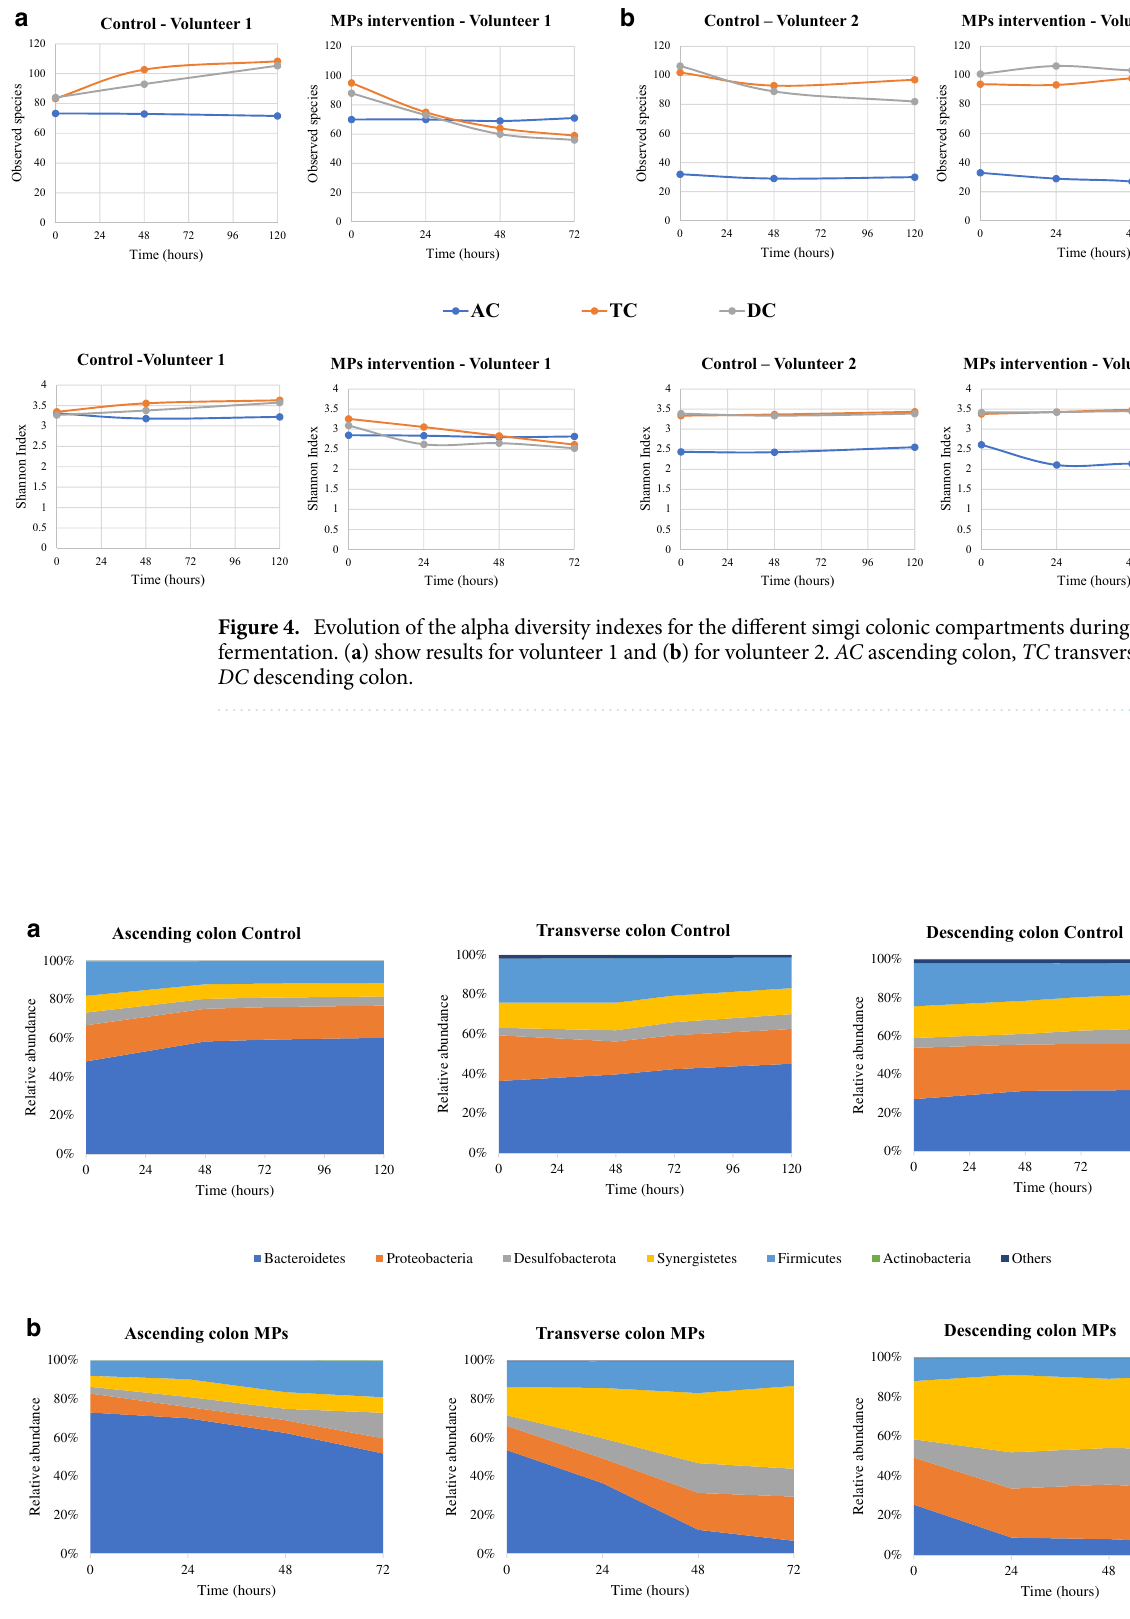
Figure 5. Evolution of the relative abundance at phylum level for the different simgi colonic compartments during colonic fermentation in volunteer 1. ( a ) show results for control period while ( b ) show the effect of MPs intervention. Graphs include the taxa with a relative abundance > 0.5% in at least one of the time points of one simgi colonic